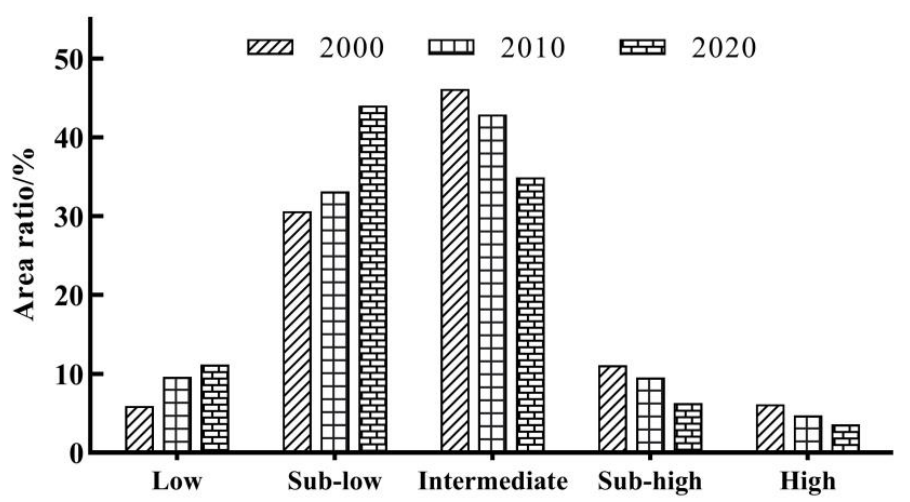
Figure 10. Proportion of ESV levels.